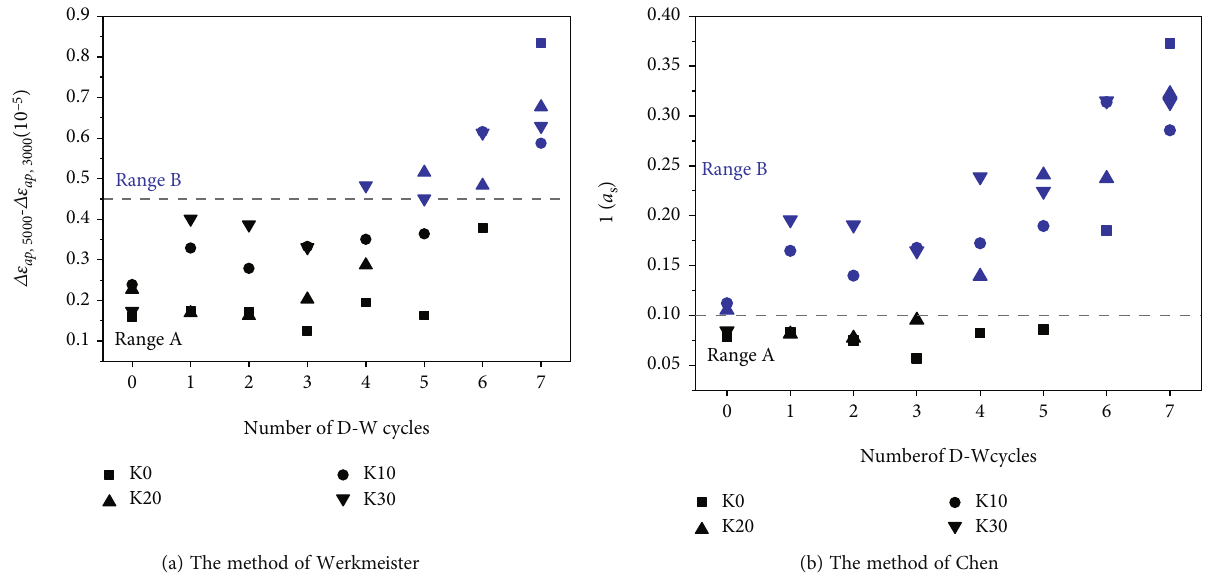
Figure 17: Classi fi cation of permanent axial strain of GRS under D-W